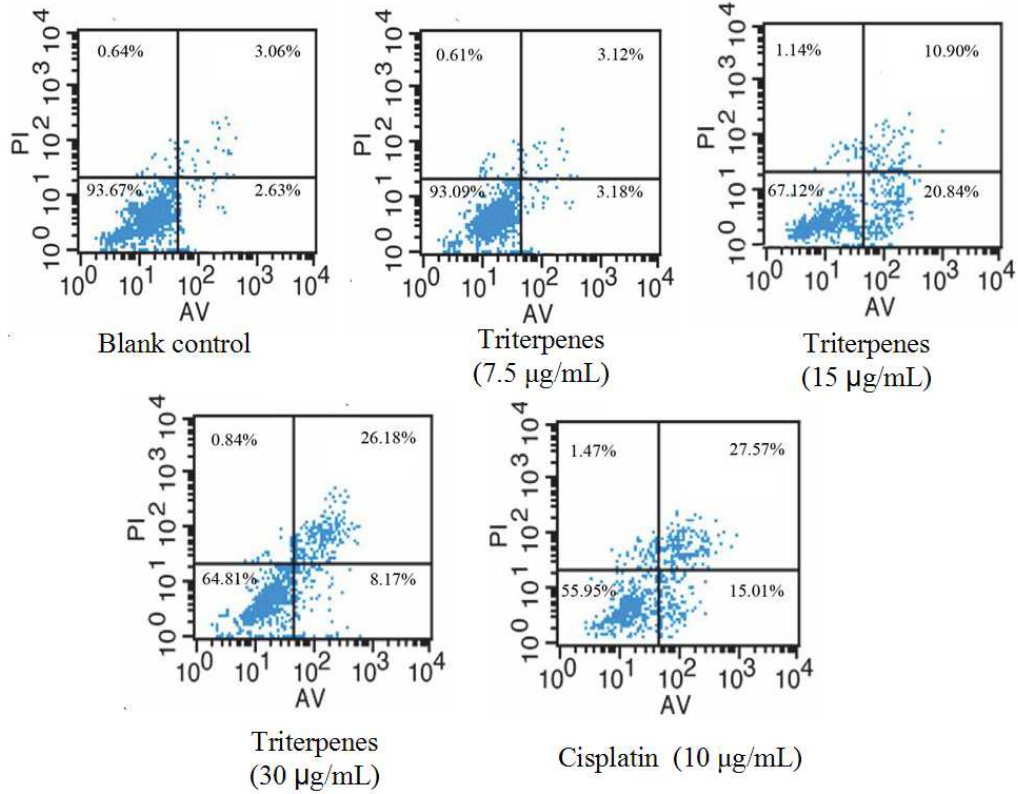
triterpenes of GLK at a concentration of 7.5 μ g/mL, 15 μ g/mL and 30 μ g/mL for 36 h